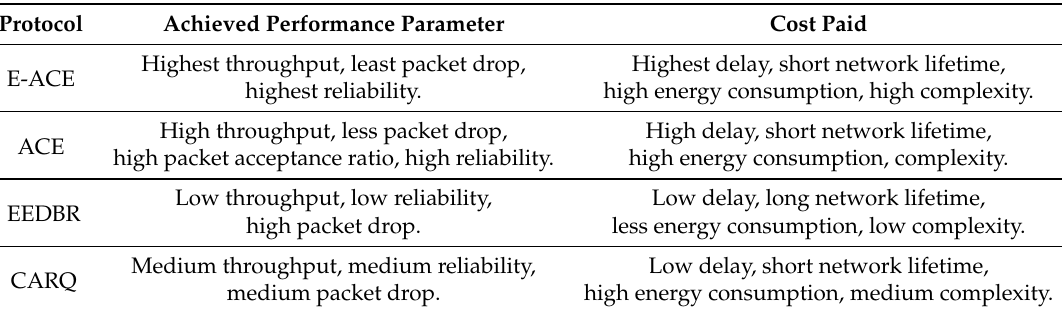
Table 3. Performance trade-offs for ACE and